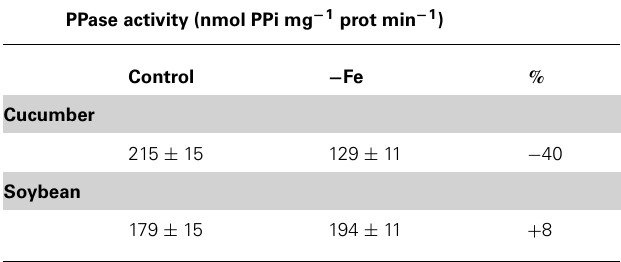
Table 2 |Vacuolar H + -PPase activity determined on tonoplast enriched fractions isolated from roots of 8-day-old cucumber and 11-day-old soybean plants grown in the presence (control) and in the absence of iron ( − Fe).